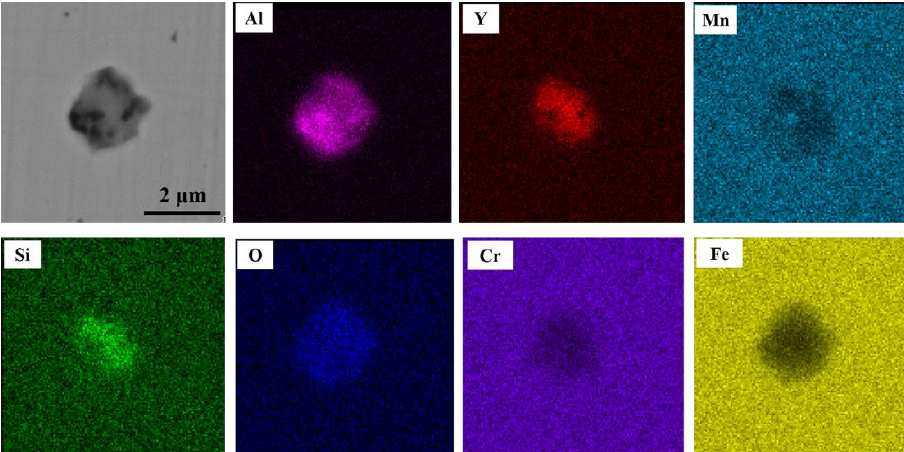
Figure 6. Mapping analysis of typical oxide inclusions after heating.